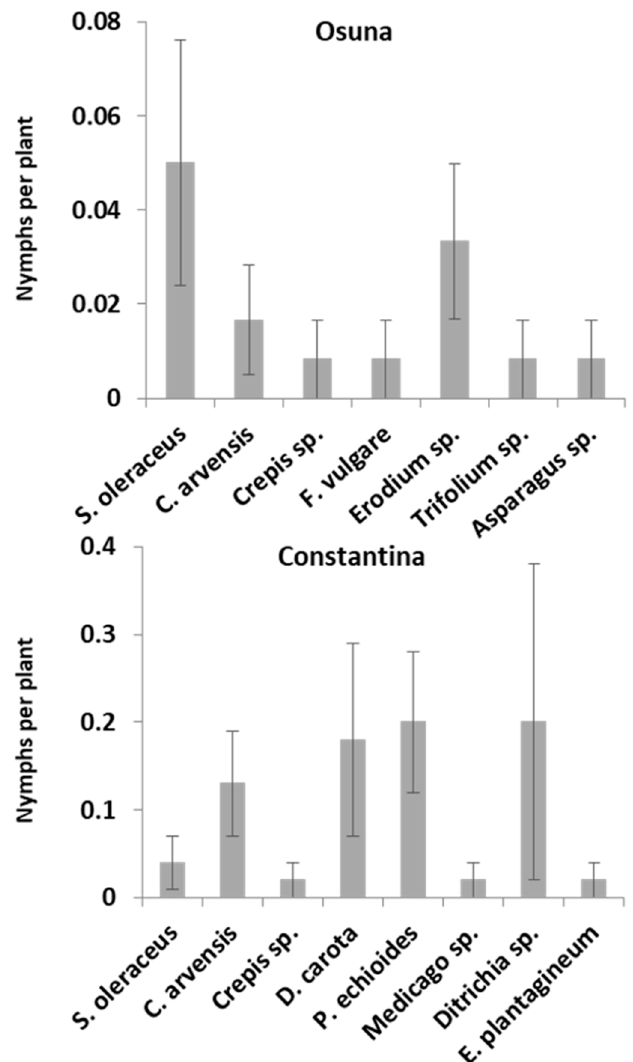
Figure 4. Host plants of the P. spumarius nymphs in Constantina and Osuna (Sevilla). Nymphs per plant is given as mean ± SEM.